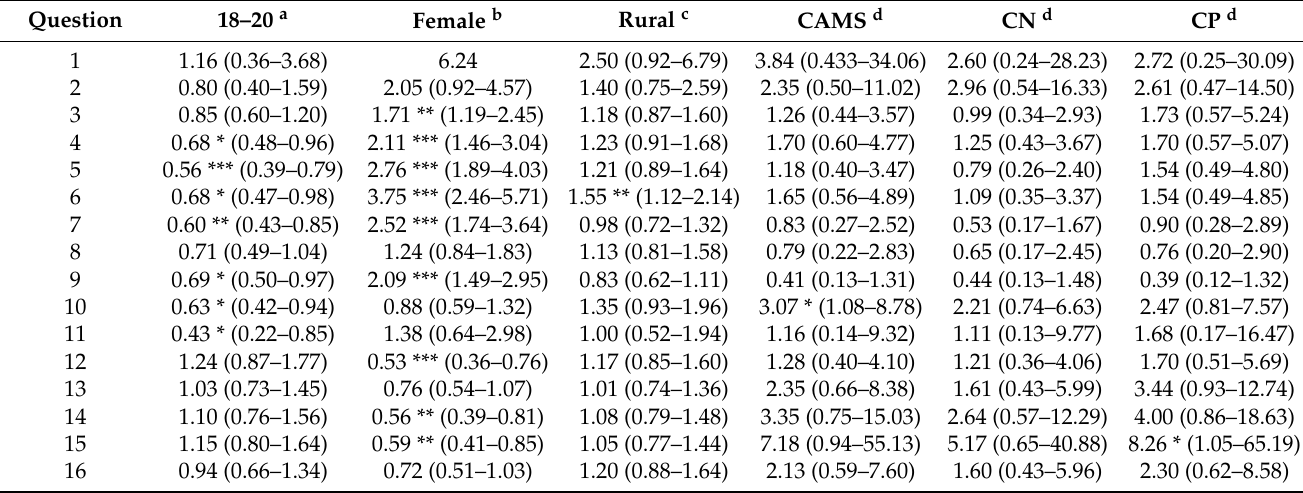
Table 3. Multivariable logistic regression for the association of students’ characteristics and respective survey